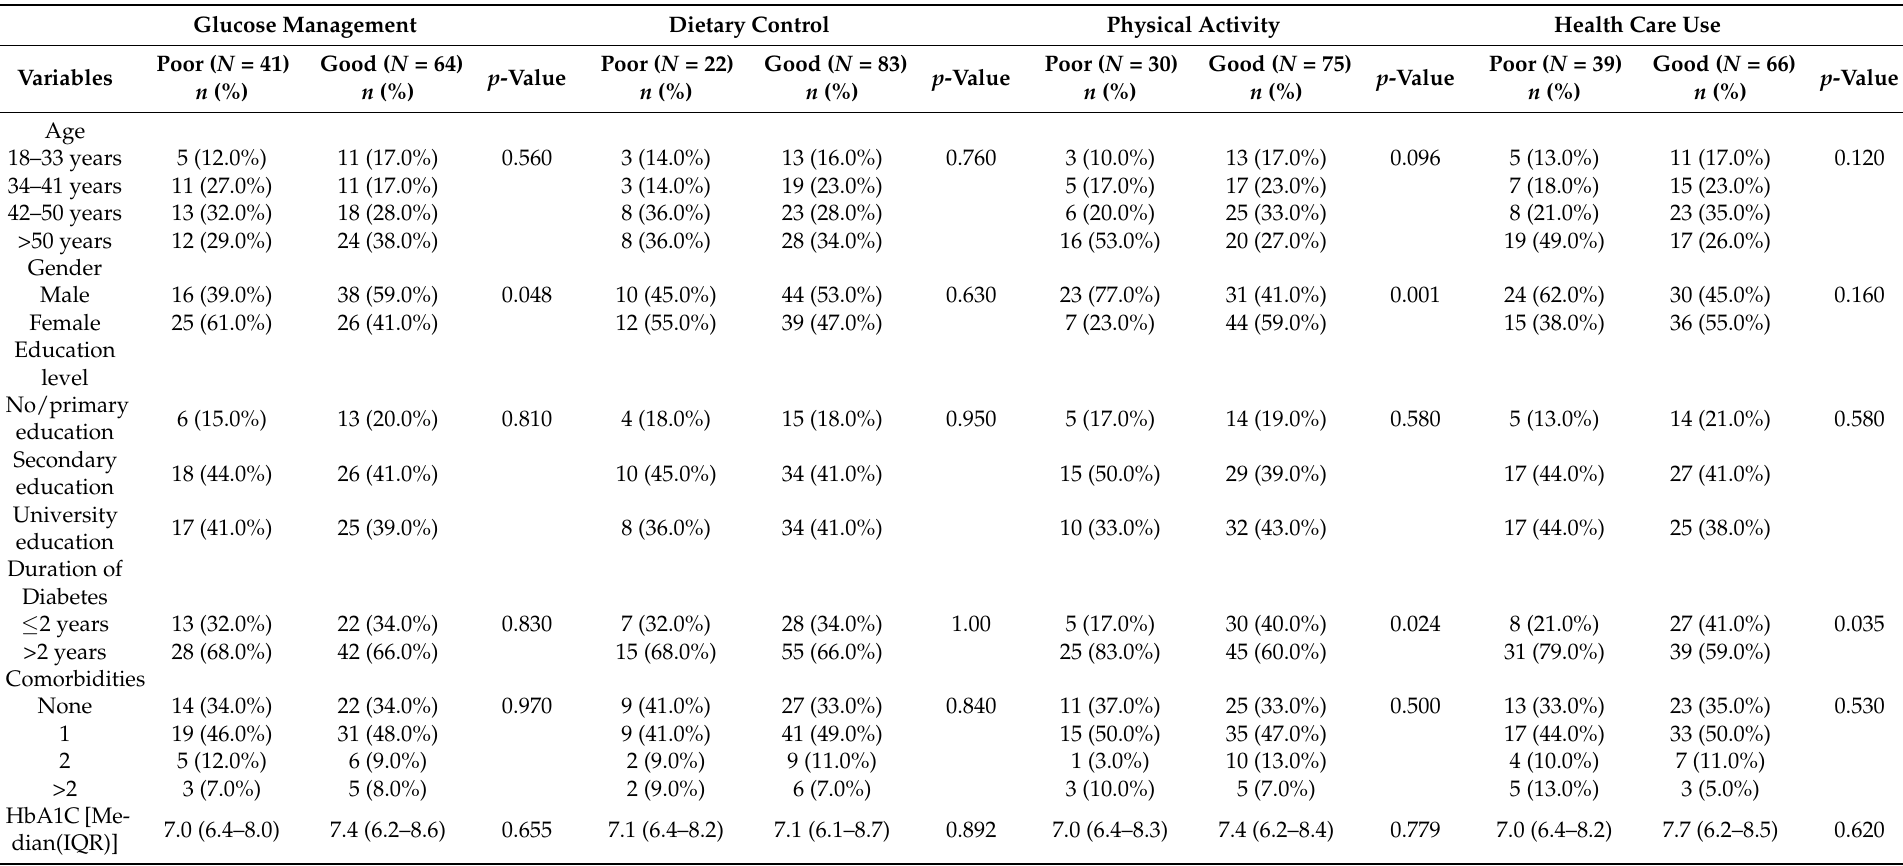
Table 3. Diabetes self-management subscales status according to participants’ baseline